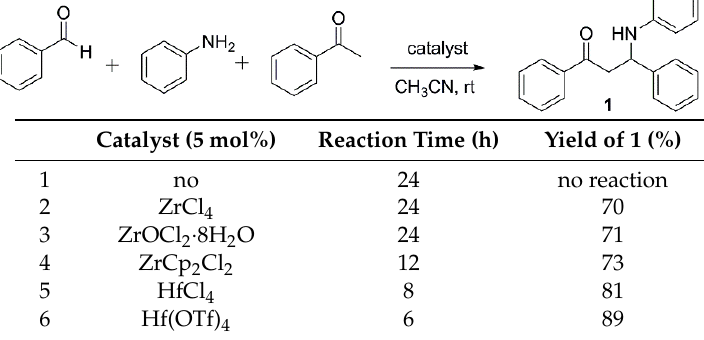
Table 2. Solvent effect on the Hf(OTf) 4 -catalyzed Mannich reaction a